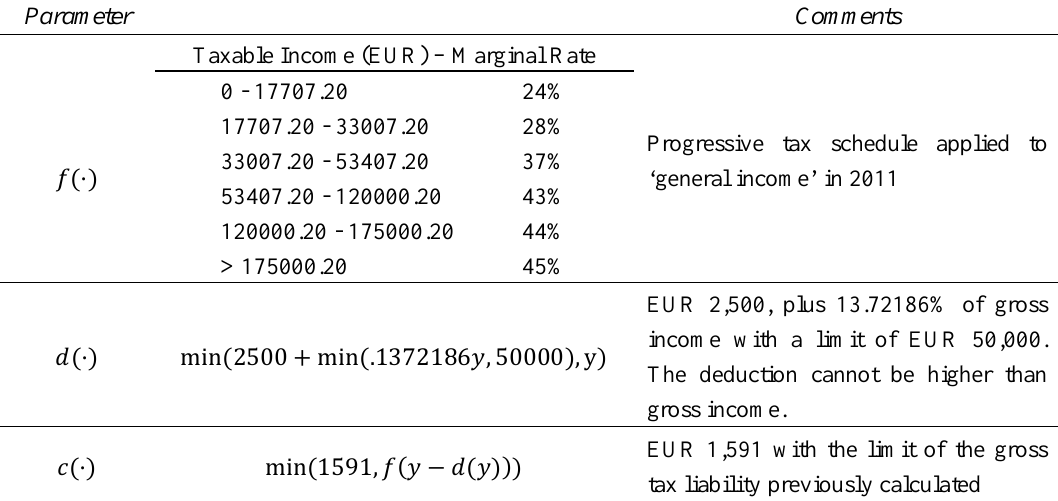
Table 2: Design parameters of the stylized tax equivalent to the 2011 Spanish PIT Parameter